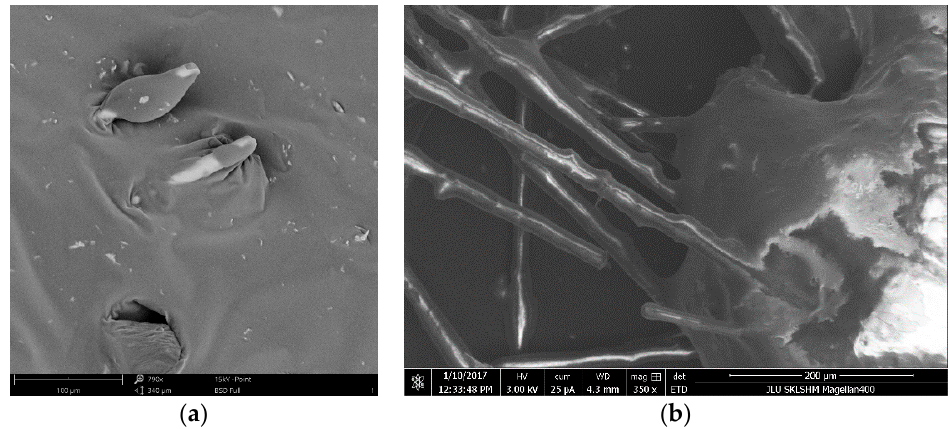
Figure 4. Images of modified asphalt and asphalt mixture. ( a ) SEM images of modified asphalt; ( b ) SEM images of modified asphalt mixture.